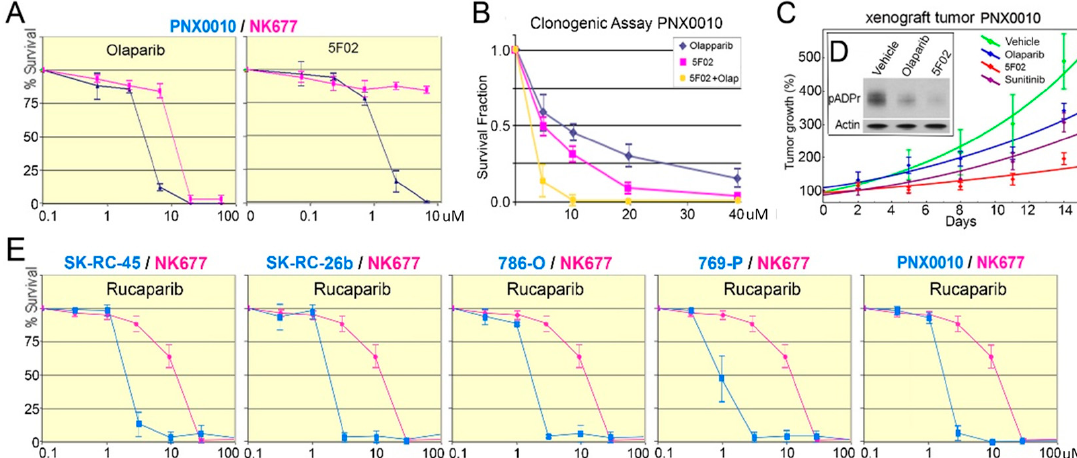
Figure 2. PARP-1 inhibitors affect ccRCC viability, proliferation and xenograft growth. ( A ) NAD-like and non-NAD-like PARP-1 inhibitors olaparib and 5F02, respectively, affect patient-derived ccRCC PNX0010 cell line viability. 5F02 eliminated PNX0010 cells (IC50—1.8 µ M) with almost no cytotoxicity to normal cells, while olaparib suppressed viability of both normal (IC50—14.7 µ M) and cancer cells (IC50—7.2 µ M). ( B ) PARP-1 inhibitors suppress malignancy potential of cancer-derived cells PNX0010. Calculation of cell survival rate was based on clonogenic assays. Cells were plated into 24-well plates. Cells were allowed to adhere overnight and were treated with a non-NAD-like inhibitor (5F02) (magenta), olaparib (blue), and both (red) for 14 days. Colonies were counted and plotted on the graph. Inhibition of pADPr by olaparib and 5F02 is shown in Figure S3. ( C ) Tumor growth of PNX0010 xenografts is diminished by PARP-1 inhibitor treatments with olaparib (blue) and 5F02 (red), as well as the classical anti-ccRCC drug sunitinib (purple). Growth of tumor without any treatment is shown in green. The most profound effect is demonstrated for 5F02 compared to control group ( p < 0.01) and olaparib ( p < 0.05) group. ( D ) Western blot analysis shows the reduction of pADPr level in tumors upon olaparib and 5F02 PARPs inhibition. Actin level is shown as loading control. ( E ) Treatment of ccRCC cell lines 786-O, 769-P, SK-RC-45, SK-RC-26b and normal NK677 with PARP-1 inhibitor rucaparib demonstrates the potential reduction of proliferation rate. Rucaparib eliminated normal cells (IC50—15.2), SK-RC-45 (IC50—1.38 µ M), SK-RC-26b (IC50—1.31 µ M), 786-O (IC50—1.29 µ M), 769-P (IC50—0.98 µ M), PNX0010 cells (IC50—1.4 µ M). The uncropped Western Blot images can be found in Figure S3.